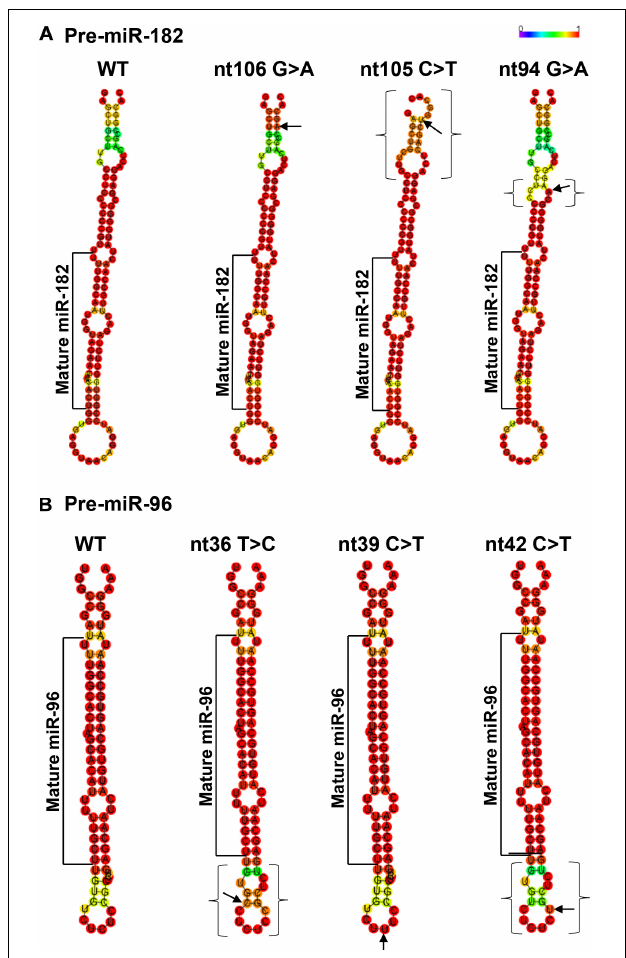
FIGURE 4 | Minimum free energy secondary structure prediction with base-pair probability on wild type (WT) hsa-pre-miR-182 (A) and hsa-pre-miR-96 (B) and their mutant forms with sequence variants. Data was compiled using publicly available software RNAfold (http://rna.tbi. univie.ac.at//cgi-bin/RNAWebSuite/RNAfold.cgi). Arrows indicate the sequence variant nucleotide. The brackets mark the areas with predicted changes of the secondary structure because of the sequence